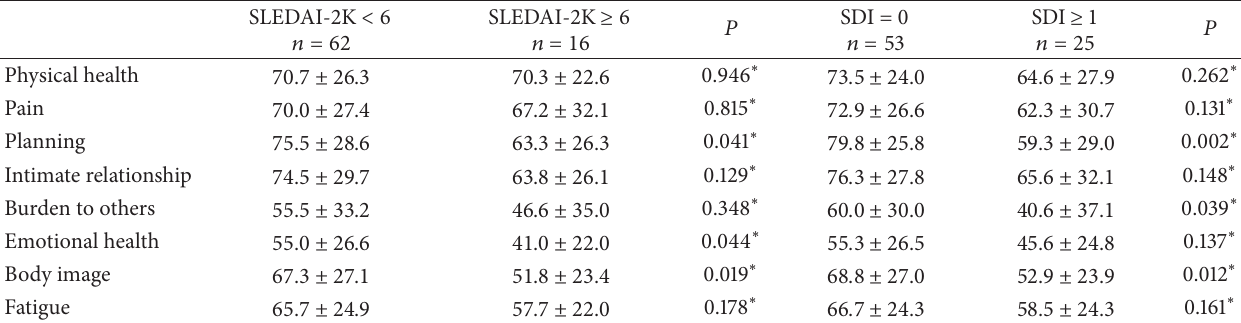
Table 4: Discriminant validity of the LupusQoL according to disease activity and